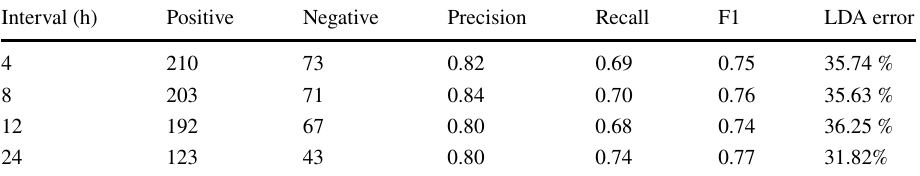
Table 4 The results: Sepsis3 criterion [3]